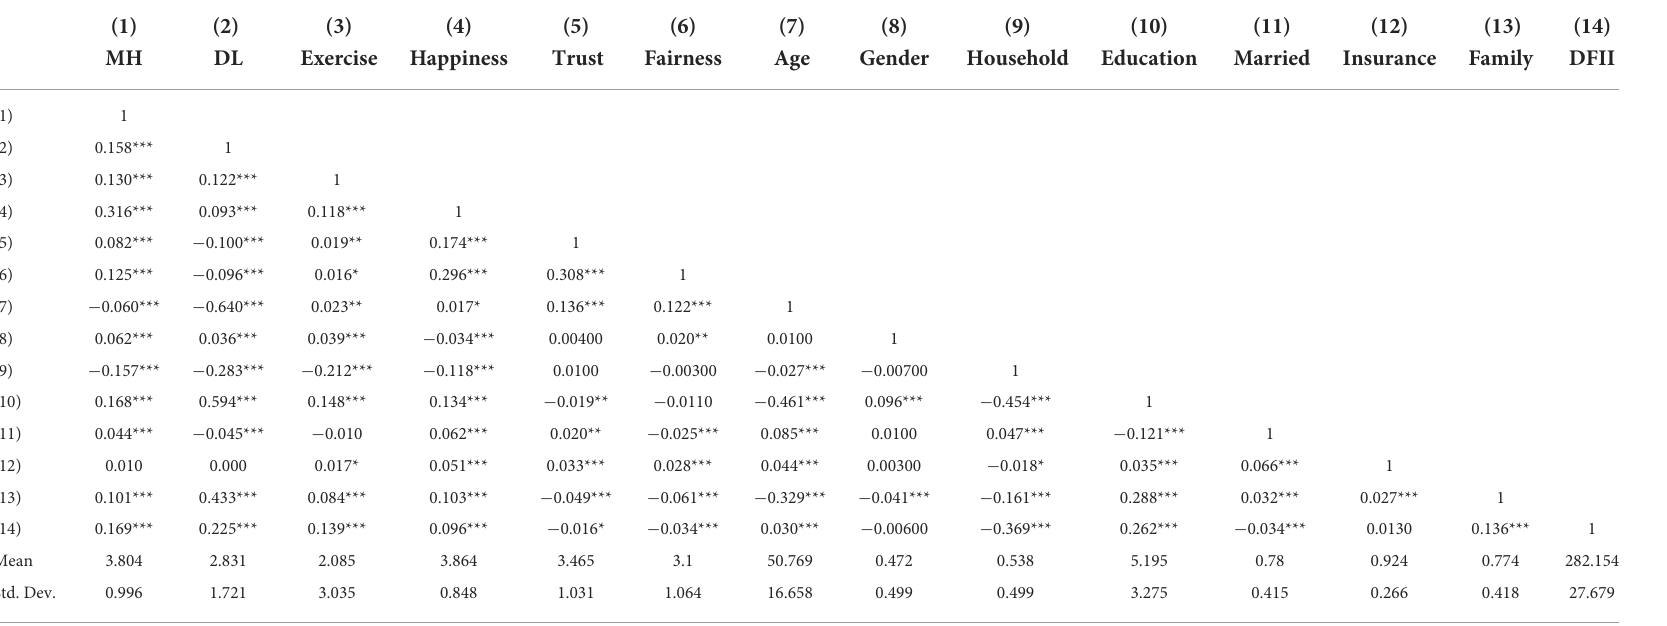
TABLE 2 Descriptive statistics and correlation coefficient matrix of